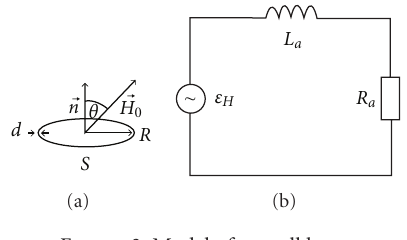
Figure 3: Model of a small loop.